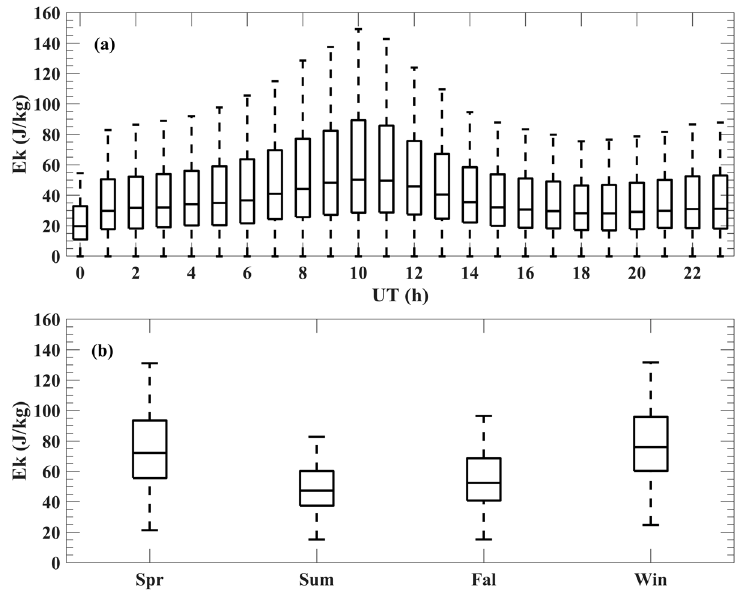
Figure 9. ( a ) Hourly and ( b ) seasonal whisker boxes for the GW kinetic energy Ek .